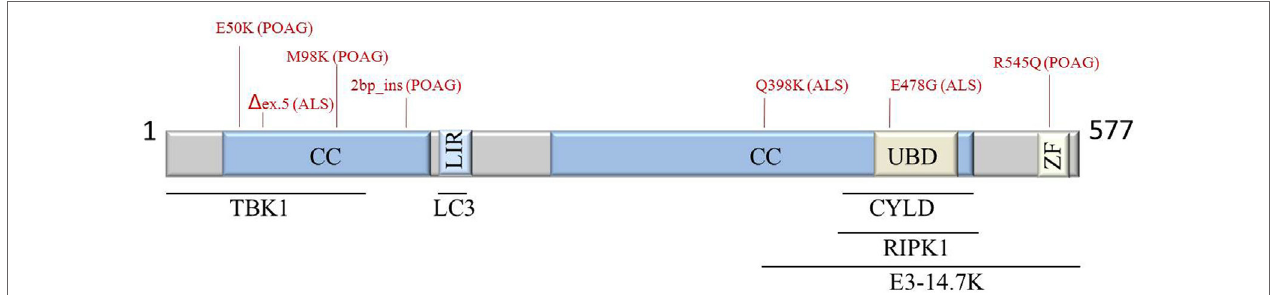
FiGURe 1 | Schematic representation of OPTN protein structure, interaction partners, and most common POAG- and ALS-associated mutations (indicated in red). Abbreviations: ALS, amyotrophic lateral sclerosis; CC, coiled coil; CYLD, cylindromatosis; E3-14.7K, early region 3 14.7 kDa protein; LIR, LC3-interacting region; POAG, primary open-angle glaucoma; RIPK1, receptor-interacting protein kinase 1; TBK1, TANK-binding kinase 1; UBD; ubiquitin-binding domain; ZF, zinc finger; OPTN,